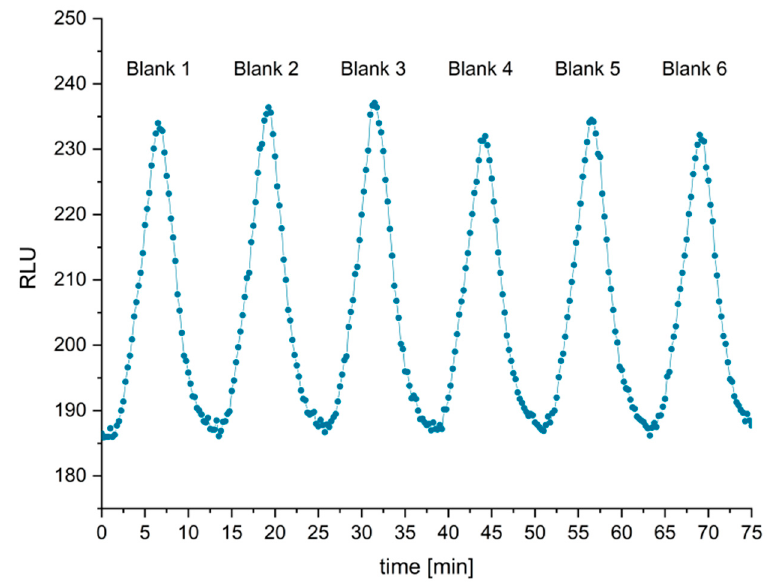
Figure 8. The injection of a sample series with six blanks achieved a standard deviation of 4.4% of the peak area.